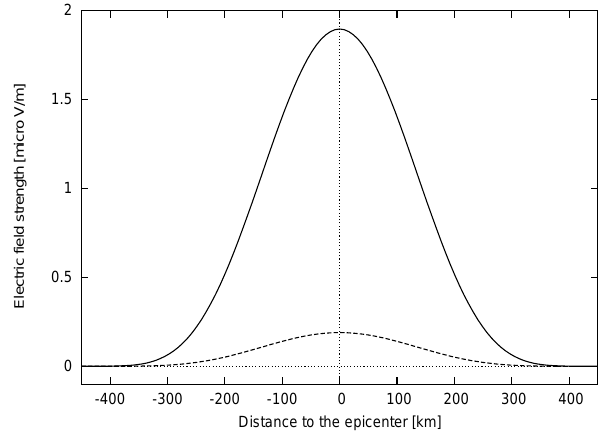
Fig. 4. Horizontal electric field E x (x,z up ) in the night-time iono- sphere with 6 P = 0 . 1 S (solid line) and 6 P = 1 S (dashed line).